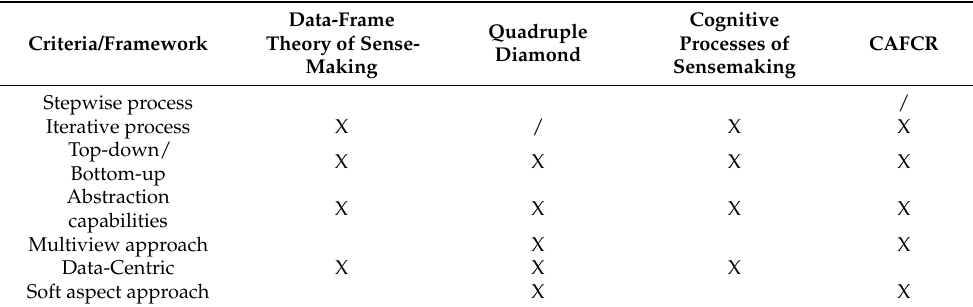
Table 1. Frameworks for Data Sensemaking in Product Development.